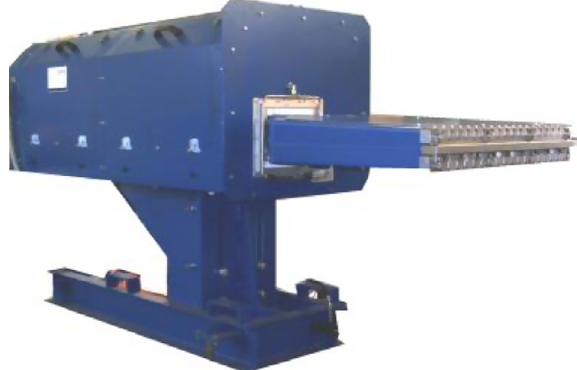
Figure 9. Jerko Dag ‘‘printer’’ (Jerko